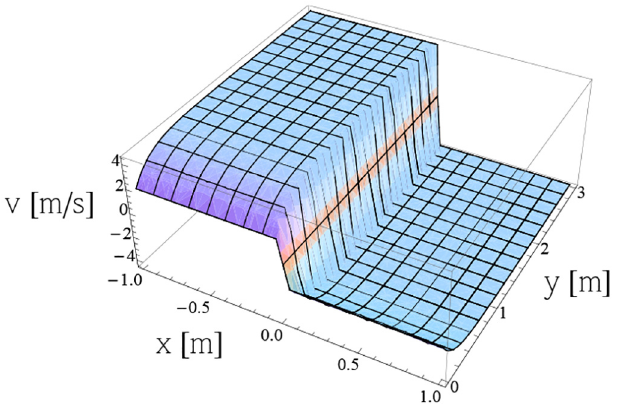
Fig 14. Variation of velocity component v from Eq (6) for m = 1, S = 0.5, λ = 0.3 for toluene at temperature